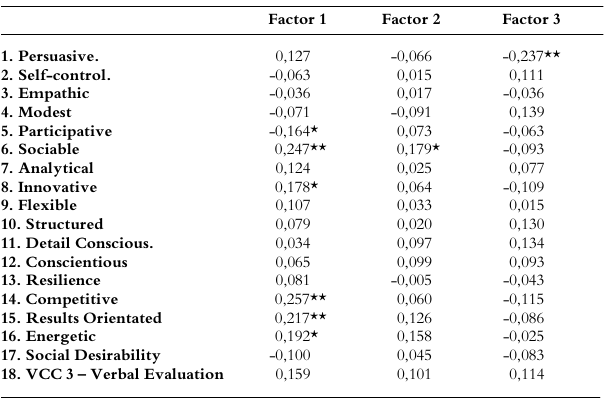
TABLE 3 CORRELATION MATRIX (18X3) OF PREDICTOR DIMENSIONS (CCSQ 5.2 ANDVCC3) WITH THECRITERIA (3 FACTORSOF THECCCI)